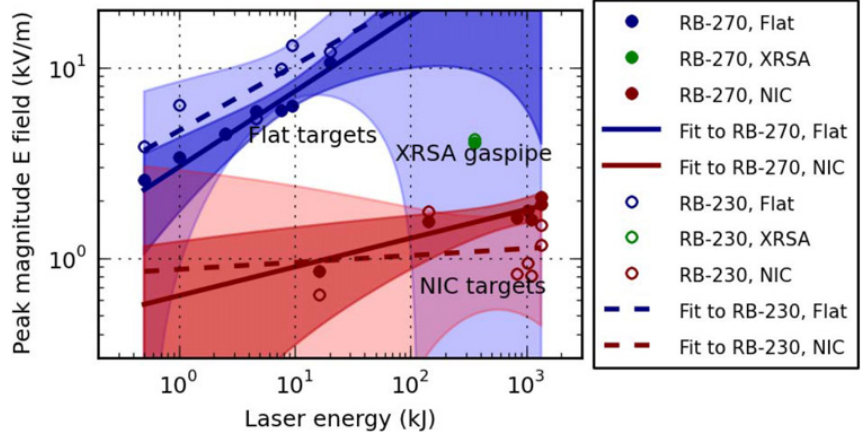
Figure 3. Peak E-field magnitude versus energy and target type with least-squares fits and corresponding 95% simultaneous confidence bands. The spectrograms also show that the EMP for the NIC campaign has relatively little high frequency content. This is also seen in Fig. 3 where we display peak E-field magnitude (using data from the high frequency RB-230 and the medium frequency RB-270 B-dot sensors) versus energy and target type, grouping into flat, XRSA, and NIC targets. For the NIC shots, the RB-230 gives lower field values